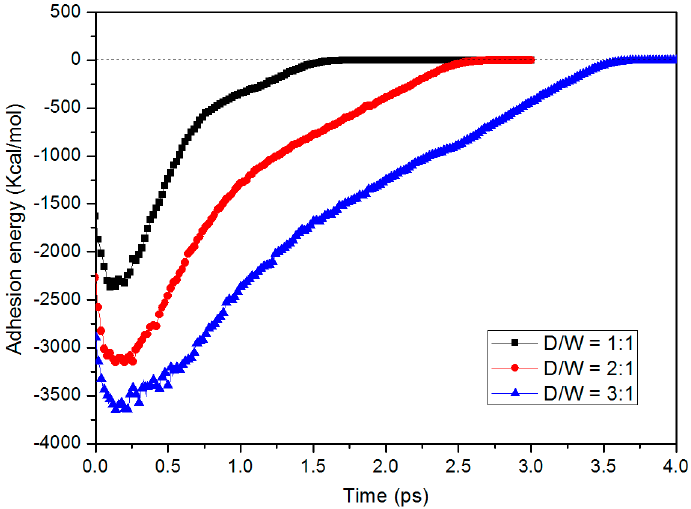
Figure 7. Adhesion energies during the demolding process with different D/W.